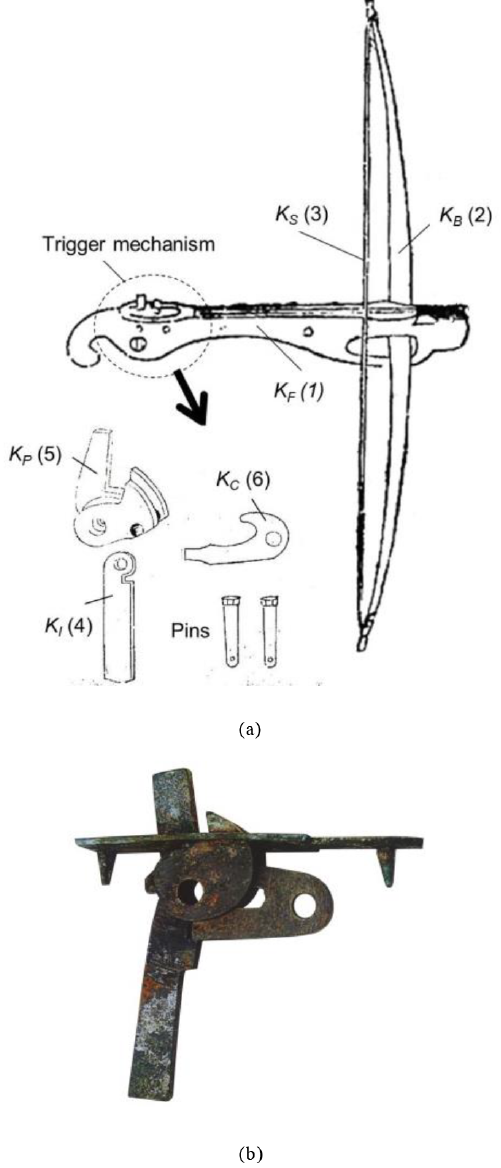
Figure 2. Original crossbow.